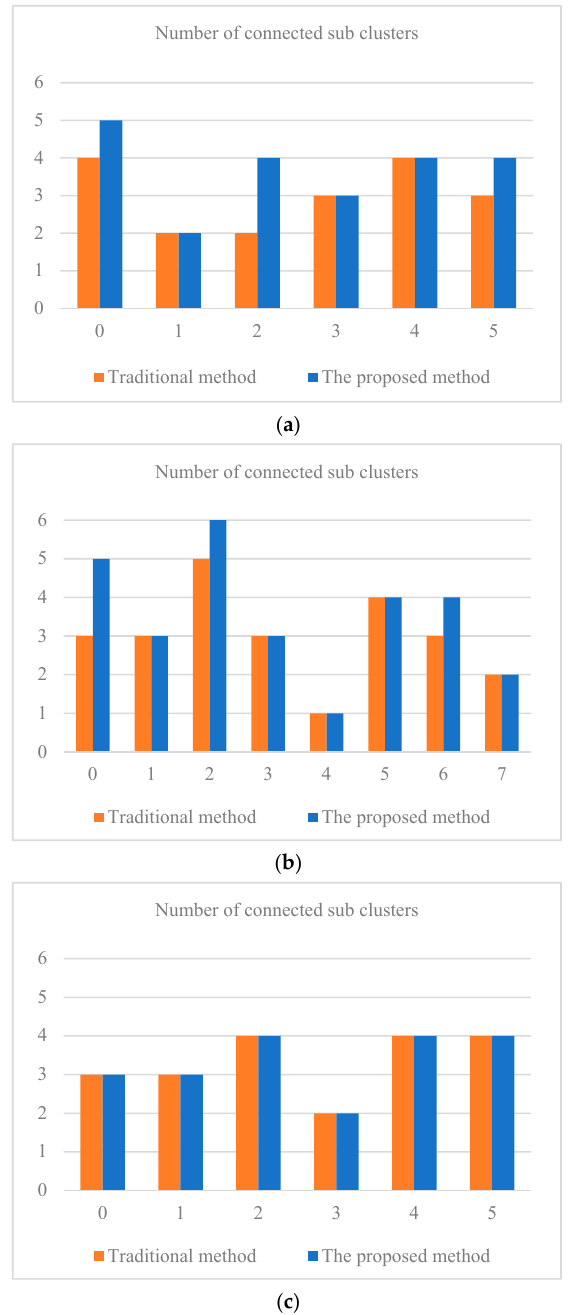
Figure 6. Connectivity of subclusters after expansion, where the horizontal coordinate represents the subcluster ID and the vertical coordinate indicates the number of subclusters with connectivity to the subclusters. The orange color represents the results of the traditional method, and the blue color represents the results of the proposed method. ( a ) The dataset is Area 6, with a subcluster partition size of 1800; ( b ) the dataset is Area 5, with a subcluster division size of 1000; ( c ) the dataset is Area 7, with a subcluster division size of 5000.